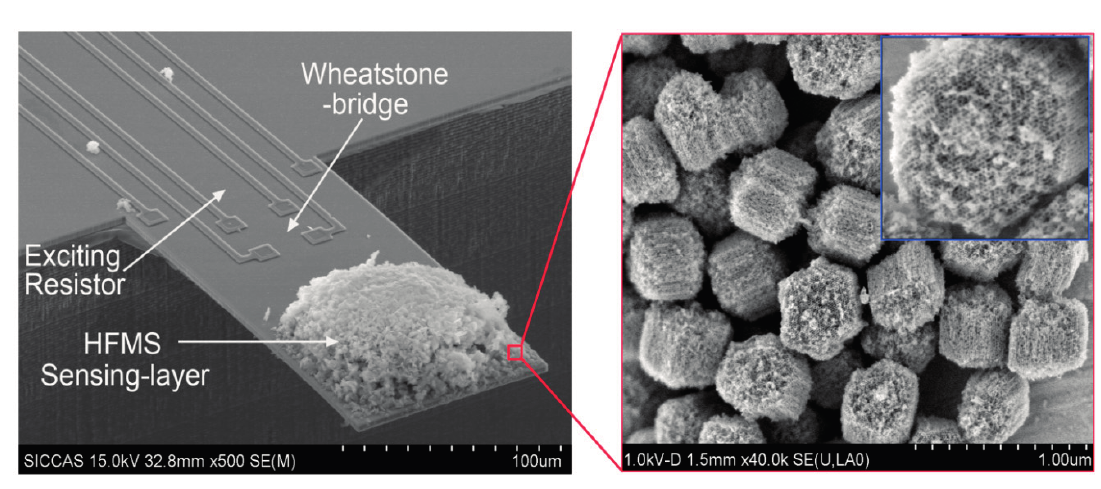
Figure 9. SEM image of the integrated silicon resonant micro-cantilever that is loaded with the HFIP-functionalized mesoporous silica sensing layer. The inset clearly shows the nanoporous structure of the sensing material. Reprinted with permission from [34].